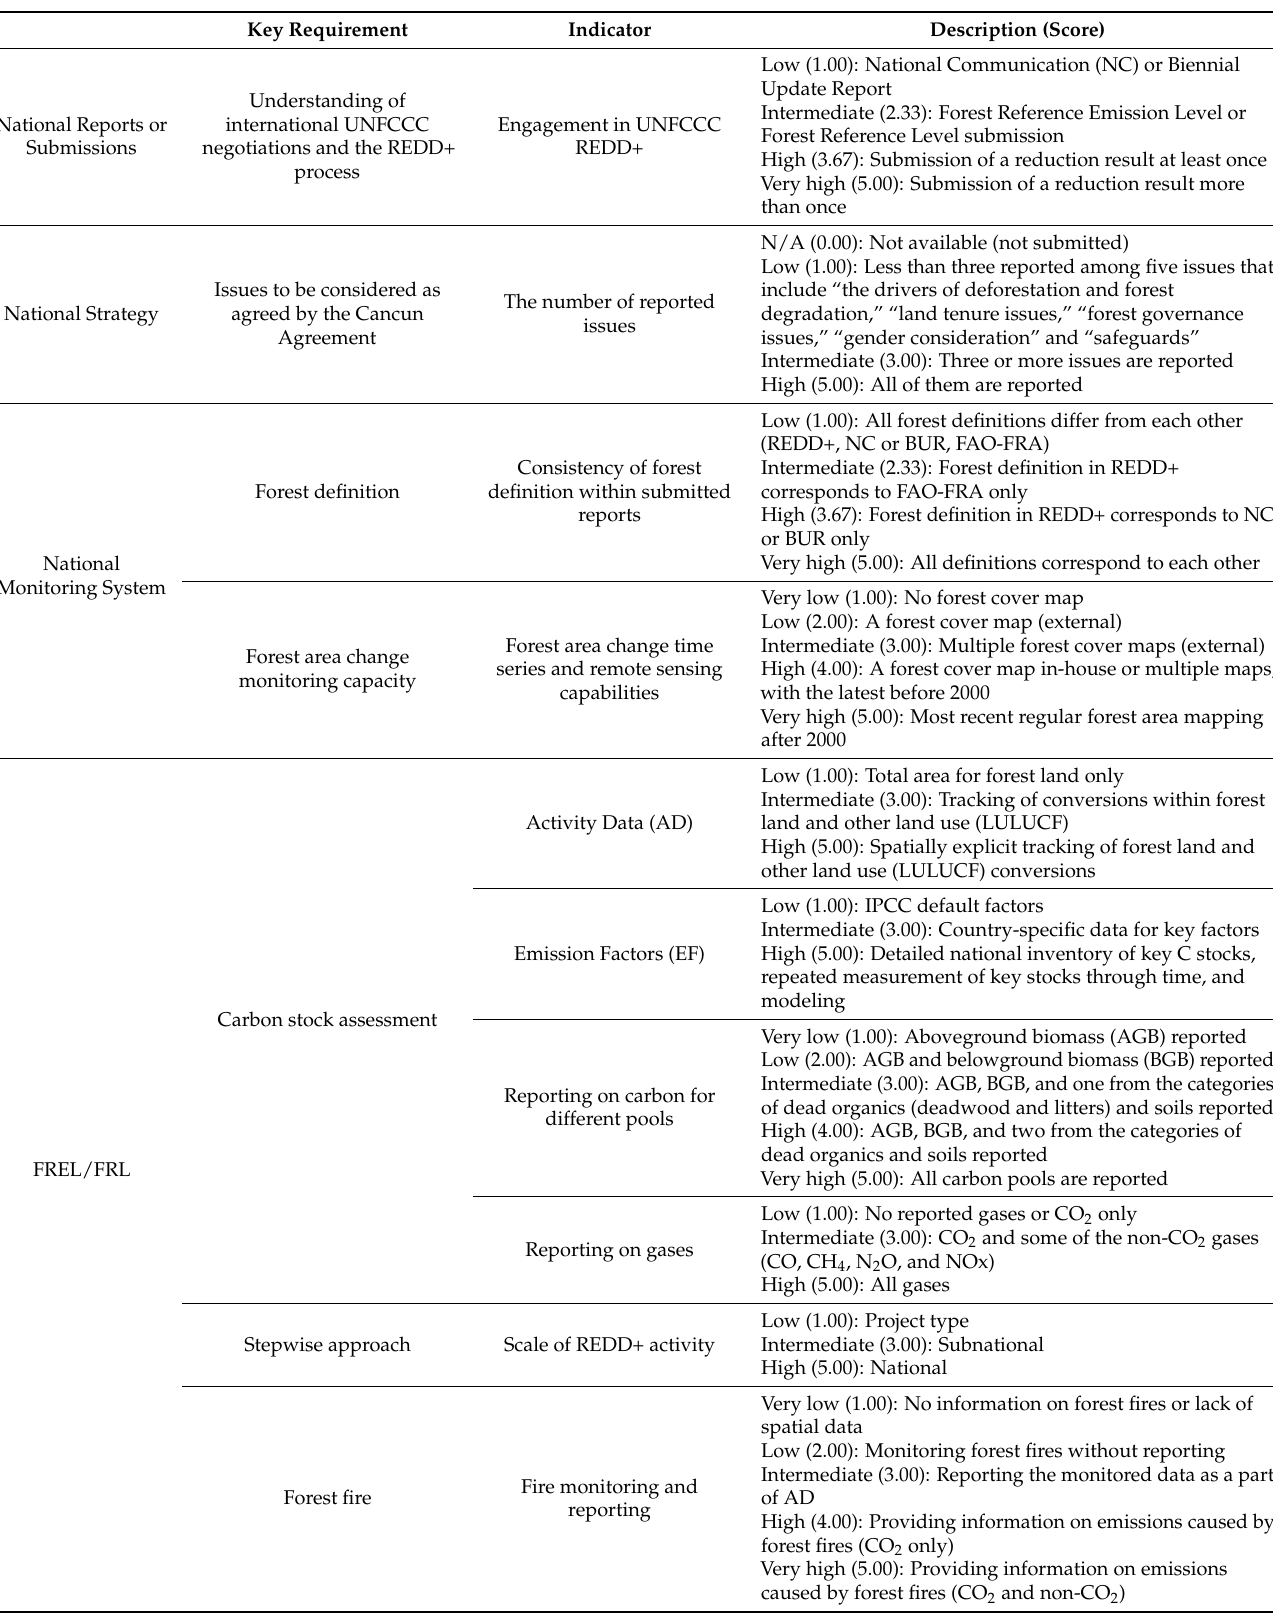
Table 2. Indicators of the REDD+ MRV evaluation